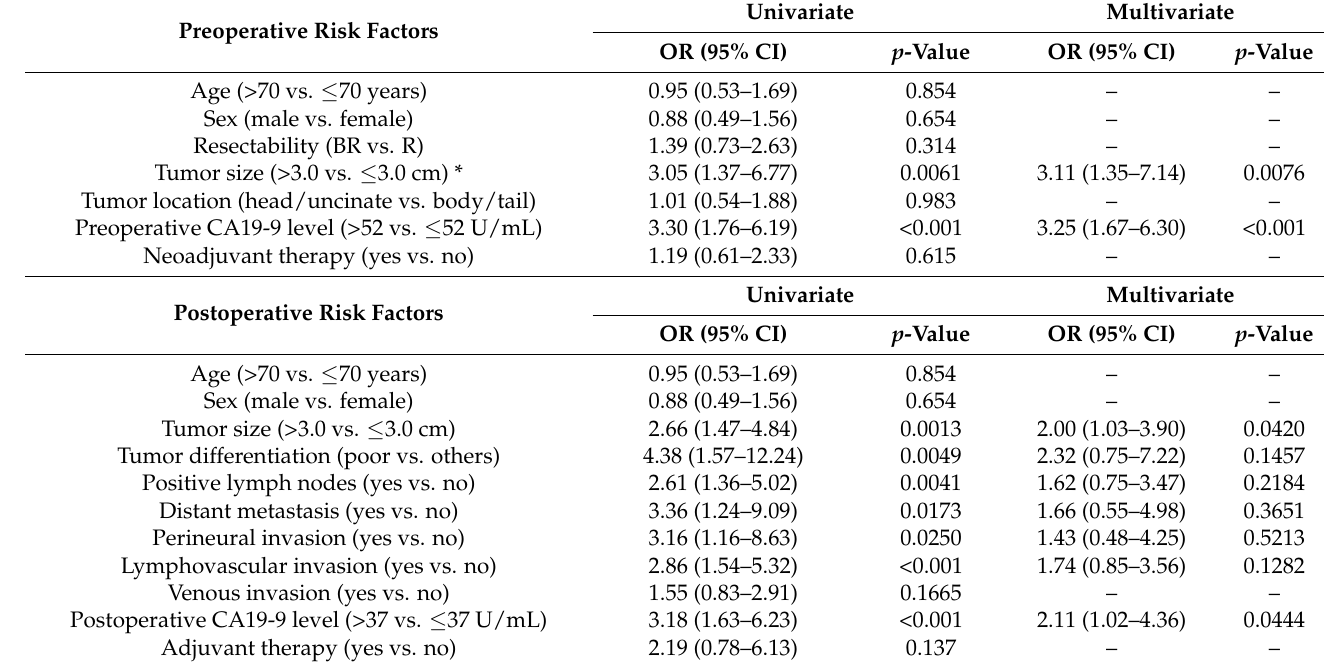
Table 3. Univariate and multivariate analyses of postoperative risk factors for an early recurrence after a resection. Univariate Preoperative Risk Factors